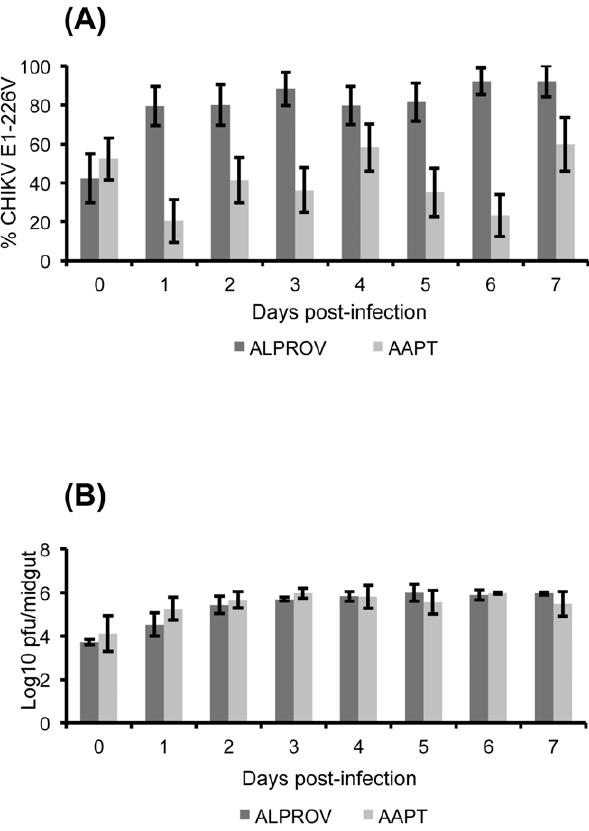
Figure 2. Effect of E1-A226V substitution on CHIKV infection in Ae.aegypti (AAPT) and Ae.albopictus (ALPROV). Ae. aegypti (light- grey) and Ae. albopictus (dark-grey) were orally infected with a blood- meal containing both E1-226A and E1-226V provided at the same titer, 10 6.5 pfu/mL. Every day, 5 mosquitoes were sacrificed to isolate the midgut. The proportion of E1-226V compared to E1-226A (A) and the number of infectious particles (B) were determined. Error bars show the confidence intervals (95%) for % CHIKV E1-226V and the standard deviations for Log10 pfu/midgut. 226A were very low and variable ranging from 18.7 6 13.1% at day 2 pi to 16.7 6 11.6% at day 7 pi. For ALPROV, mean proportions of E1-226V were higher than 80% from day 3 to day 7 pi. The five ALPROV mosquitoes tested at days 2, 4 and 7 pi have only ensured the dissemination of E1-226V variant. Thus this variant is preferentially disseminated in Ae. albopictus . On the other hand, the E1-226A variant preferentially disseminates in Ae. aegypti AAPT mosquitoes. When comparing the proportion of the E1- 226A in the midgut and saliva of AAPT mosquitoes at day 3, 5 and 7 pi, the E1-226A variant was preferentially disseminated and transmitted in Ae. aegypti AAPT (Fisher’s exact test: p , 0.05). When the number of infectious viral particles in salivary glands was compared between AAPT and ALPROV, regardless of the variant, no significant differences were found between both species (Kruskal-Wallis test: p . 0.05) (Figure 4B). In both species, CHIKV was visualized by confocal microscopy in salivary glands at days 3 and 7 pi (Figure S1).